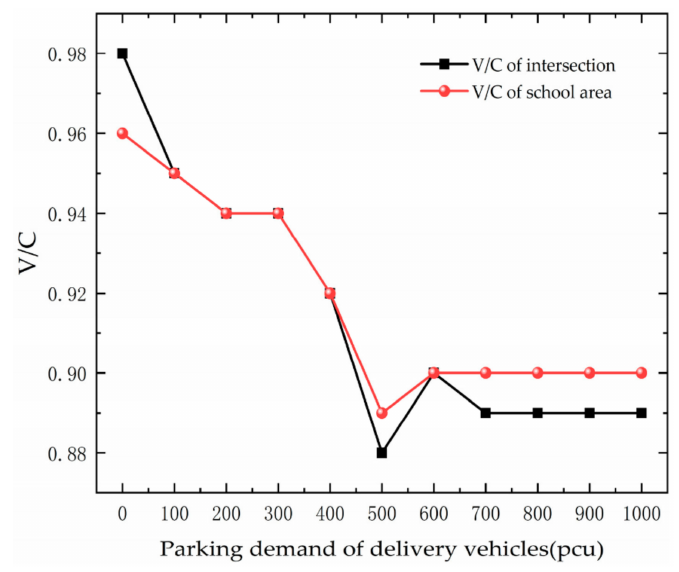
Figure 16. Variation trend of Saturation with PDD.